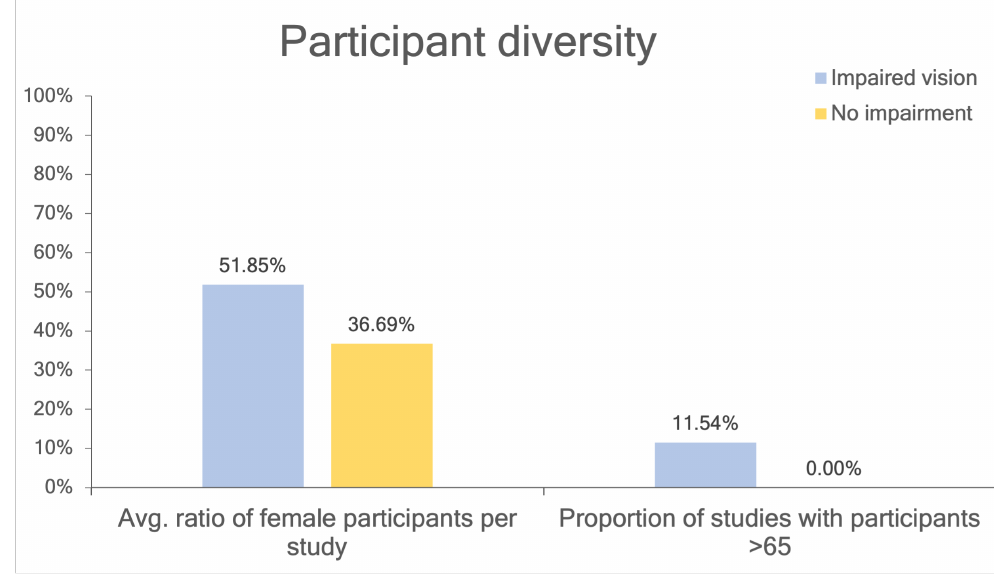
Figure 6. Participant group diversity in terms of age and